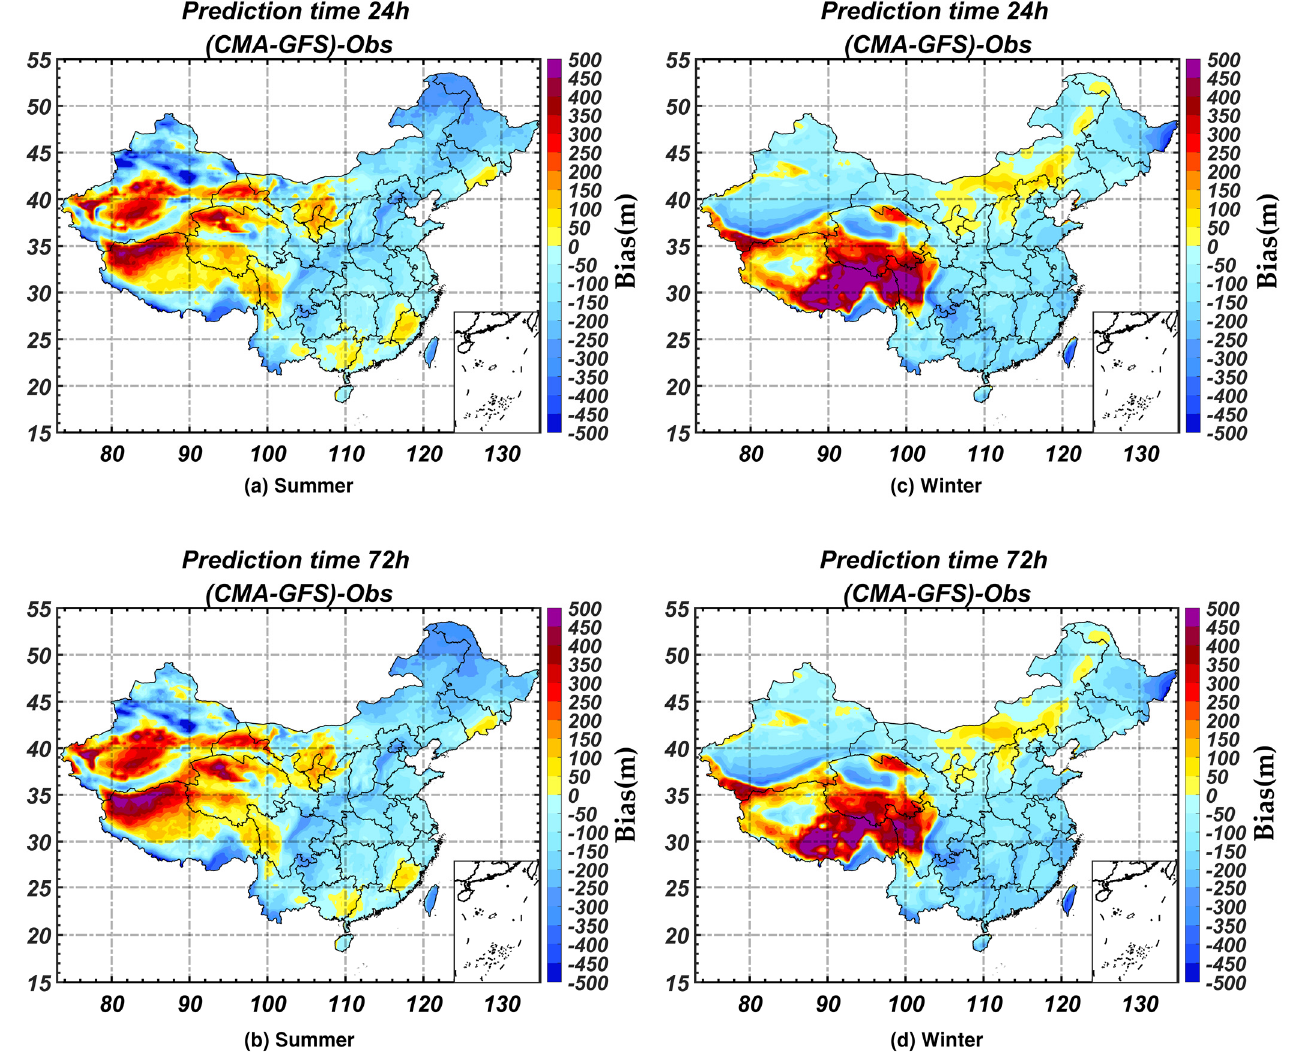
Figure 4. The 24 h ( a , c ) and 72 h ( b , d ) forecasting bias of CMA-GFS compared with the observation in summer ( a , b ) and winter ( c , d ).